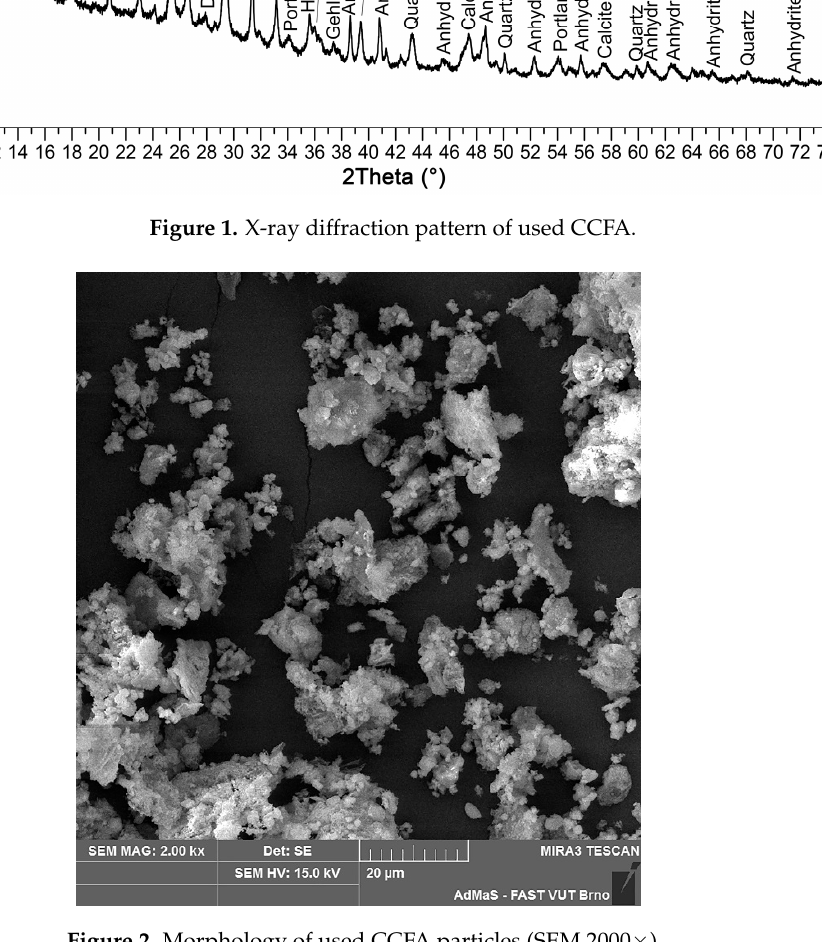
Figure 2. Morphology of used CCFA particles (SEM 2000×).